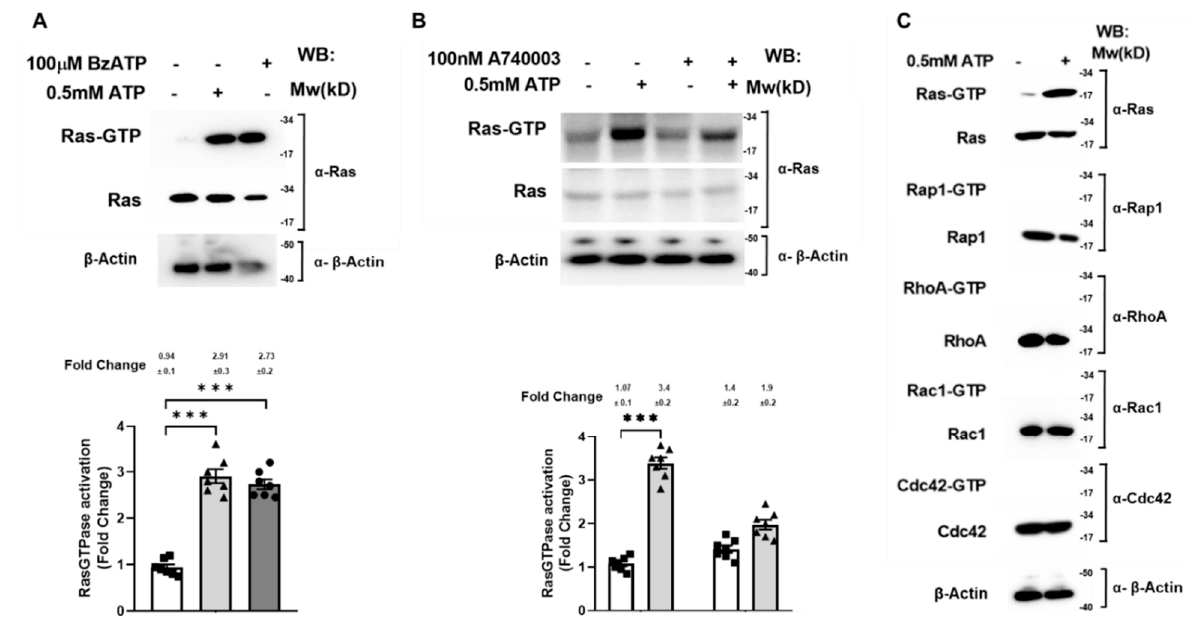
Figure 2. The P2X 7 receptor-mediated specific Ras activation in SN4741 cells. The SN4741 cells were serum-starved overnight and treated, or not, with 0.5 mM ATP for 5 min and lysed. ( A ) Cell lysates were used to measure Ras, Rap1, RhoA, Rac1, and Cdc42 activation by the affinity precipitation assay. The precipitated active GTPases (binds to GTP) and the total GTPases expression levels were analyzed by Western blotting using a specific antibody. The results are representative of five independent experiments. ( B ) Serum-starved SN4741 cells were treated, or not, with 0.5 mM ATP for 5 min, and 100 µ M BzATP for 10 min, or ( C ) previously treated with or without 100 nM A740003 for 1 h before a 5-min stimulation, or not, with 0.5 mM ATP and lysed. Cell lysates were used to measure Ras activation by the affinity precipitation assay. The precipitated active Ras (Ras-GTP) and the total Ras expression level were analyzed by Western blotting using an anti-Ras antibody. The β -Actin amounts present in the samples analyzed in lower panel were examined with an anti- β -Actin antibody. Immunoblots are representative of seven independent experiments. Each histogram bar includes the values of five different samples. All values are expressed as fold change. The differences between treatments were p < 0.001 in all cases (***).